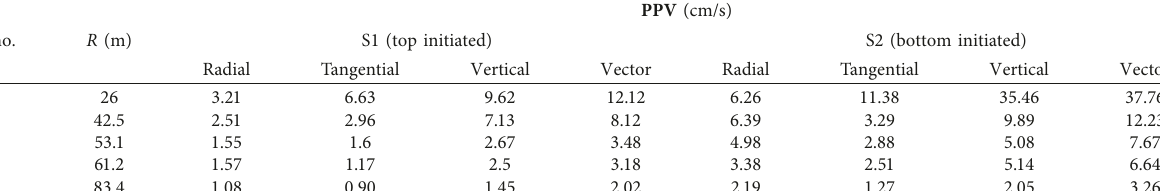
Table 6: Measured PPV s in the production blasting experiment.